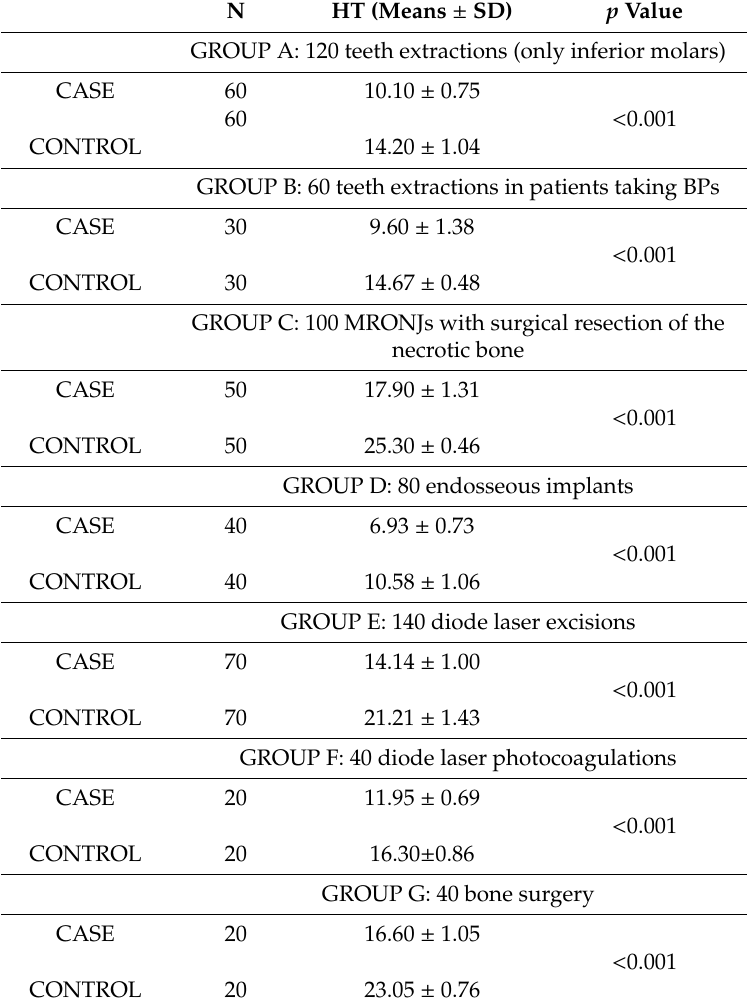
Table 1. Statistical analysis of results for each group with